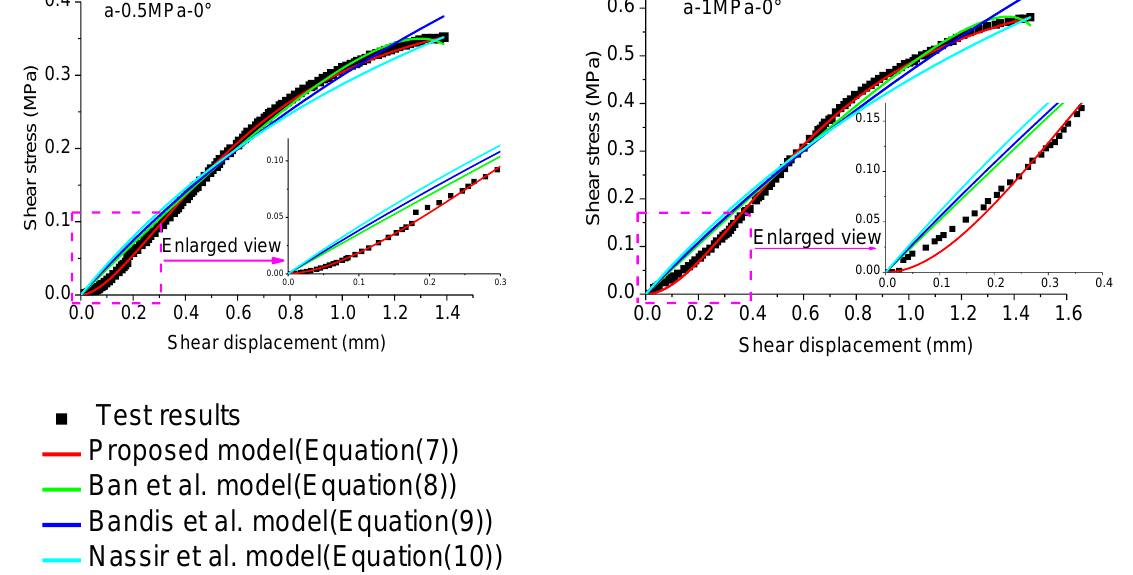
Figure 5. The comparison between each model and experimental results.